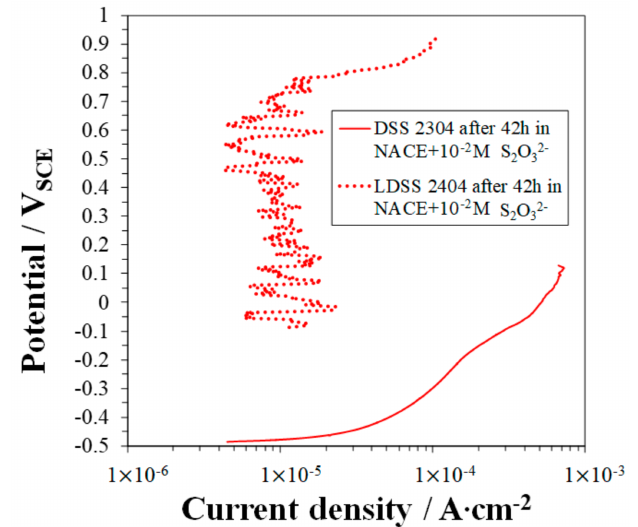
Figure 15. Polarization curves recorded on DSS 2304 and LDSS 2404 after 42 h immersion in NACE TM-0177 solution at 25 ◦ C and pH 2.7, in the presence of 10 − 2 M S 2 O 32 −